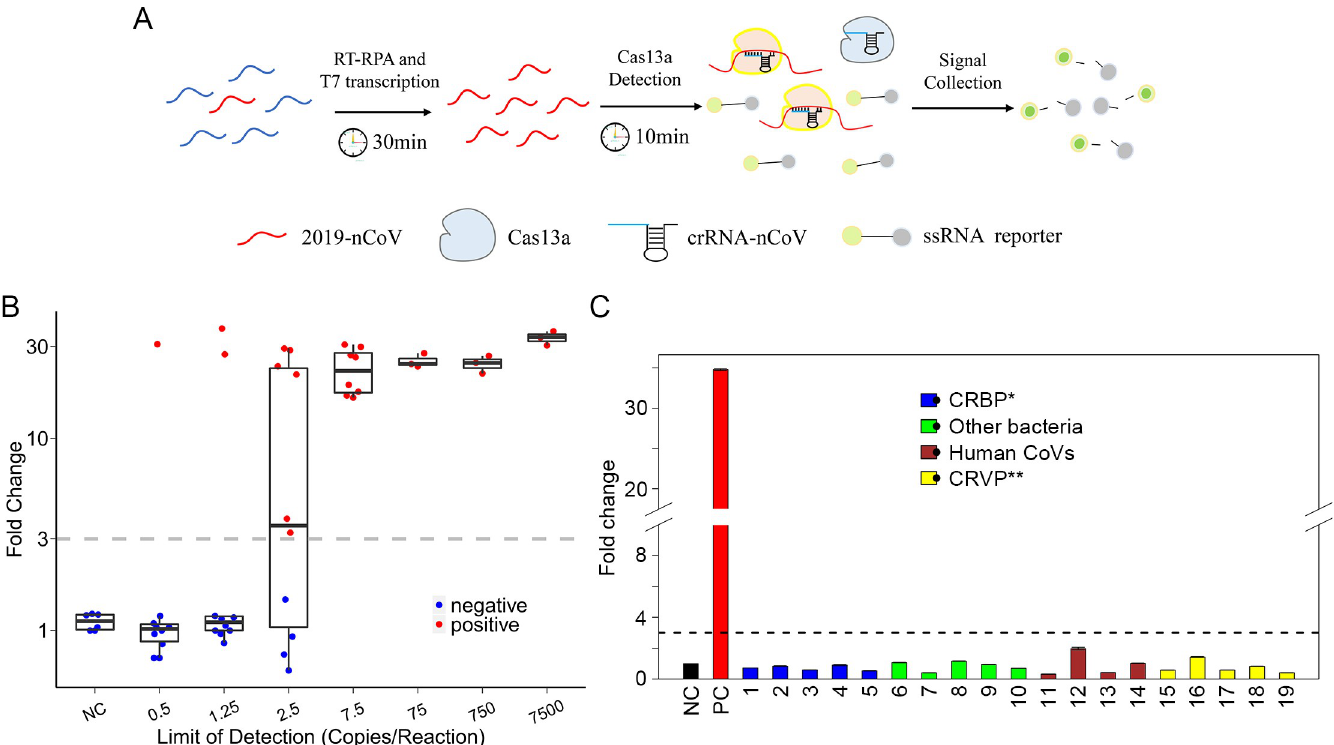
Fig 2. Analytical assessment of the sensitivity and specificity of CRISPR-COVID. (A) Schematic diagram of CRISPR-COVID. The collateral nuclease activity of Cas proteins is activated upon specific binding of gRNA to the Orf1ab gene. Fluorescent signal produced from cleaved probes is captured and indicates the presence of SARS-CoV-2; Analytic evaluation of assay performance by testing contrived negative swab samples with indicated titers of SARS-CoV-2 (B) , and various microbes as interfering materials. (CRBP, Common respiratory bacterial pathogens; CRVP, Common respiratory viral pathogens; 1, S . pneumoniae ; 2, H . influenzae ; 3, M . pneumoniae ; 4, C . pneumoniae ; 5, B . pertusiss , 6, S . mitis ; 7, S . pyogenes ; 8, S . aureus ; 9, E . coli ; 10, E . faecalis ; 11, hCoV-OC43 ; 12, hCoV-NL63 ; 13, hCoV-HKU-1 ; 14, hCoV-229E ; 15, Adenovirus Type 3 ; 16, H . influenzae B (Victoria) ; 17, H . influenzae A (H3N2) ; 18, HPIV-1 ; 19, RSV-A ) (C) . Group Blue, common respiratory bacterial pathogens; Green, Other bacteria; Brown, other CoVs; Yellow, common respiratory viral pathogens. P < 0.001 by Student’s t-test between PC and all other samples.